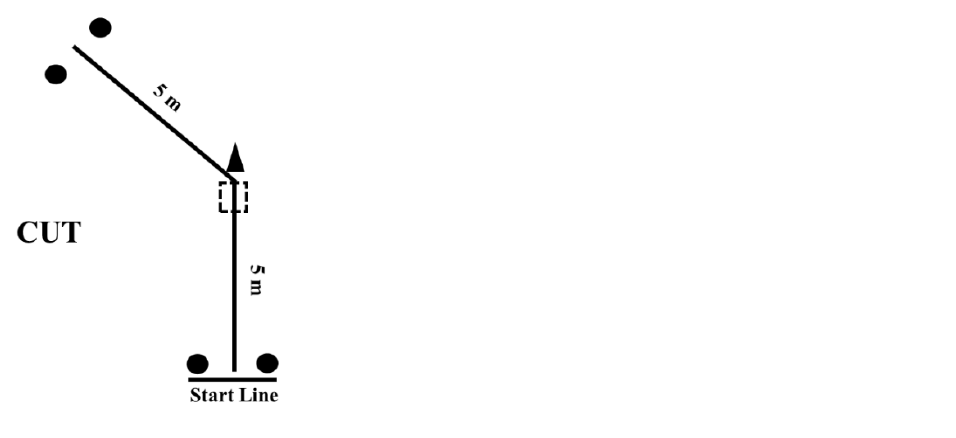
Figure 1. Schematic representation of the CUT test. Circles represent the position of the photocells. In the L-drill, participants started in a standing position, 0.3 m behind the starting line, and were required to sprint forward 5 m, cut 90 ◦ at the first cone, sprint 5 m, circle a second cone, and sprint another 5 m in the opposite direction. Then, a final 90 ◦ cut